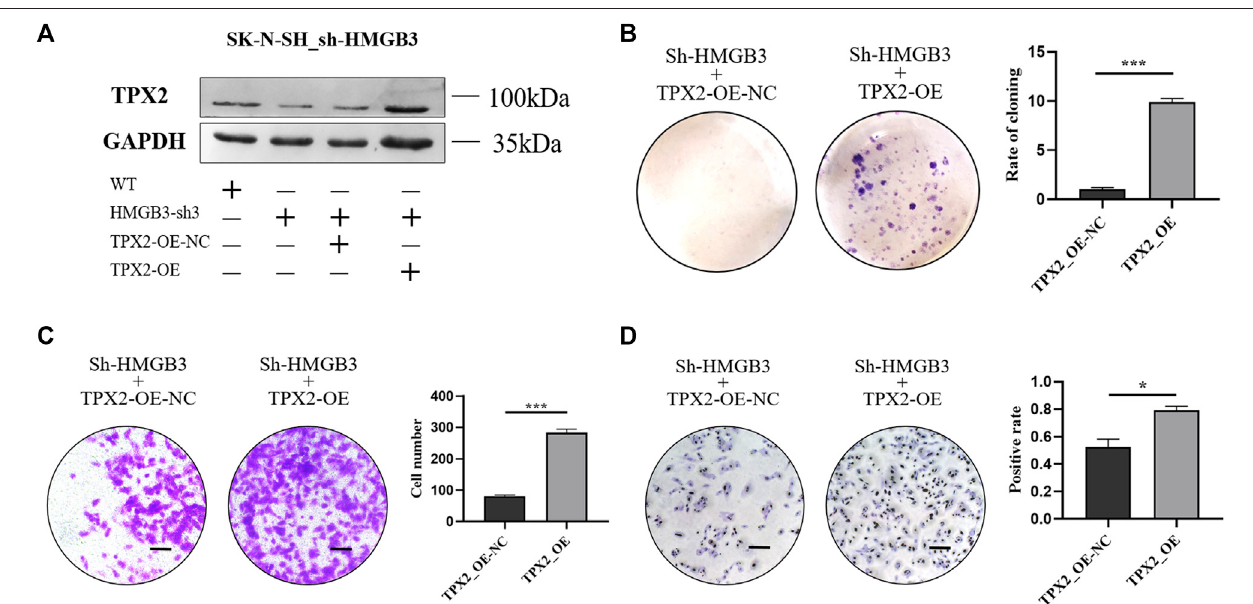
FIGURE 5 | TPX2 overexpression can reverse the inhibition of cell proliferation caused by HMGB3 knockdown in SK-N-SH cells. (A) Protein expression was detectedinsh-HMGB3SK-N-SHcellsafterTPX2over-expressionbywesternblotting. (B – D) Colonformation,Transwellassay,andimmunocytochemistryassayforsh-